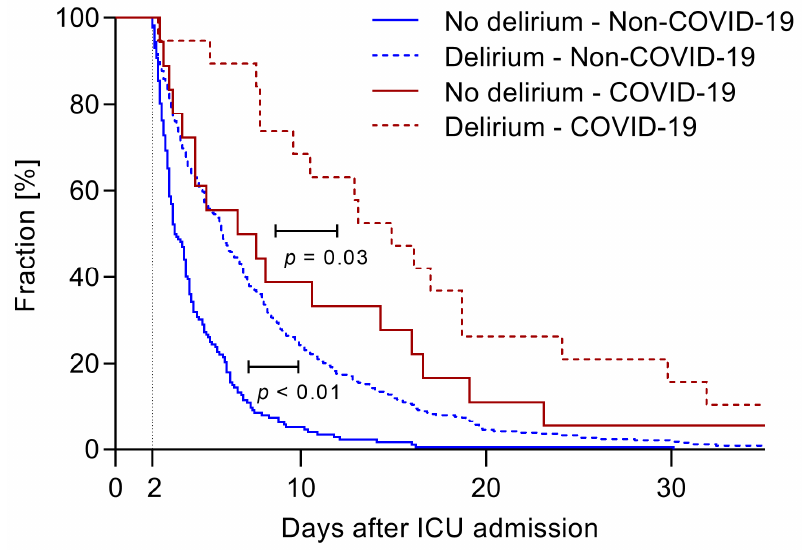
Figure 2. Duration of stay on the ICU. Graph showing ICU stay of all patients included, separated by the presence of COVID-19 and incidence of delirium .